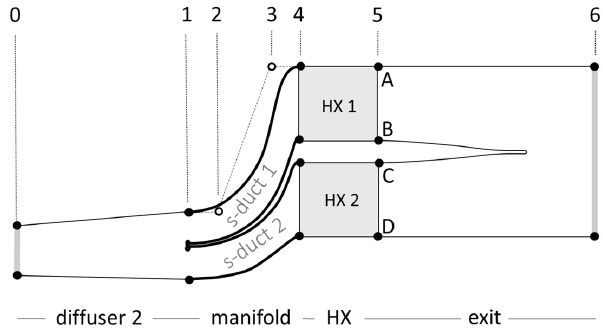
Figure 8. Model 2 (CCA2) topology.